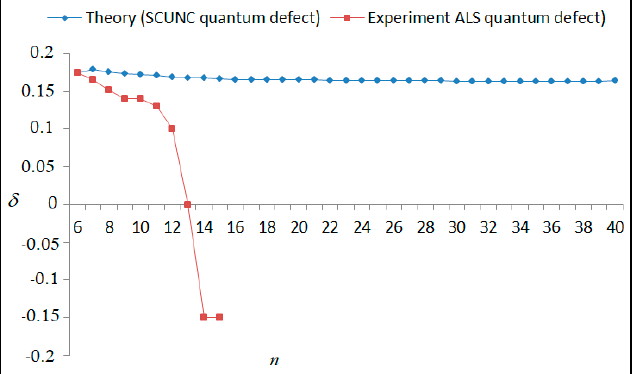
Figure 9. Variations of the quantum defect ( δ ) with the principal quantum number n for the 4 s 2 4 p 2 ( 1 D 2 ) nd ( 2 P 1/2 ) Rydberg series originating from the 2 P ° 1/2 metastable state of Se + converging to the 2 D 1 series limits in Se 2+ .